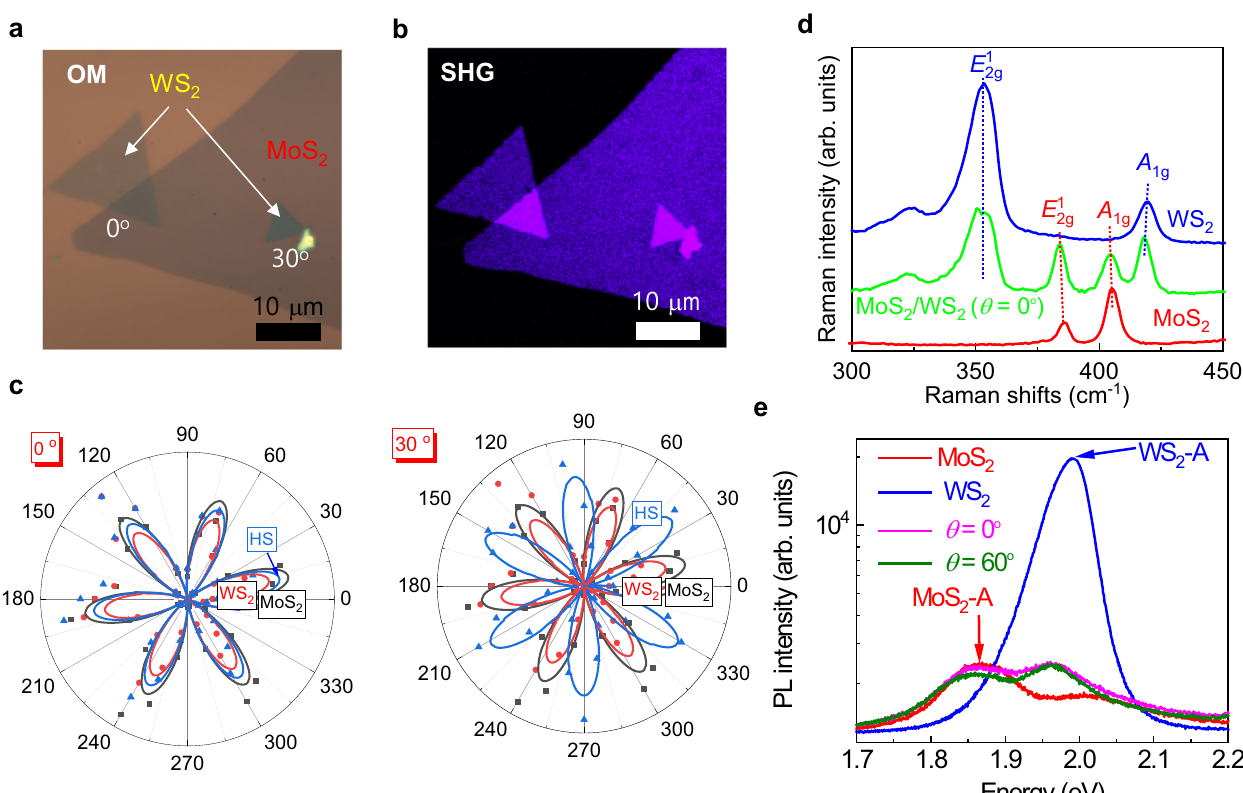
Fig. 1 Twisted MoS 2 /WS 2 heterobilayers. a , b Optical microscopy image ( a ) of typical bilayers at θ = 0 and 30°, and b corresponding SHG mapping image. c Polar plots of the polarization-resolved SH intensity as a function of azimuthal angle between the incident laser polarization and the armchair direction for the bilayers at θ = 0 and 30°. d Raman spectra of typical MoS 2 and WS 2 monolayers, and the MoS 2 /WS 2 bilayer at θ = 0°. e Photoluminescence spectra of the MoS 2 and WS 2 monolayers, and the MoS 2 /WS 2 bilayers at θ = 0 and 60°. Here, the PL peaks of the MoS 2 and WS 2 intralayer excitons (MoS 2 -A and WS 2 -A) are